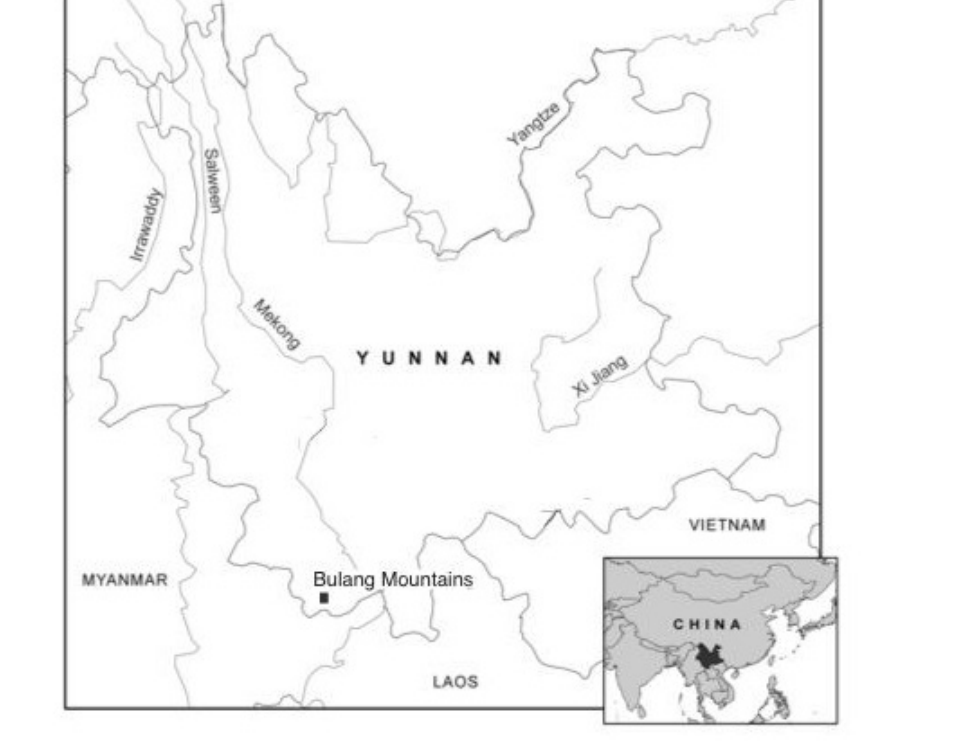
Fig. 2 . Study site in the Bulang Mountains, Menghai County, Xishuangbanna Dai Autonomous Prefecture, Yunnan,